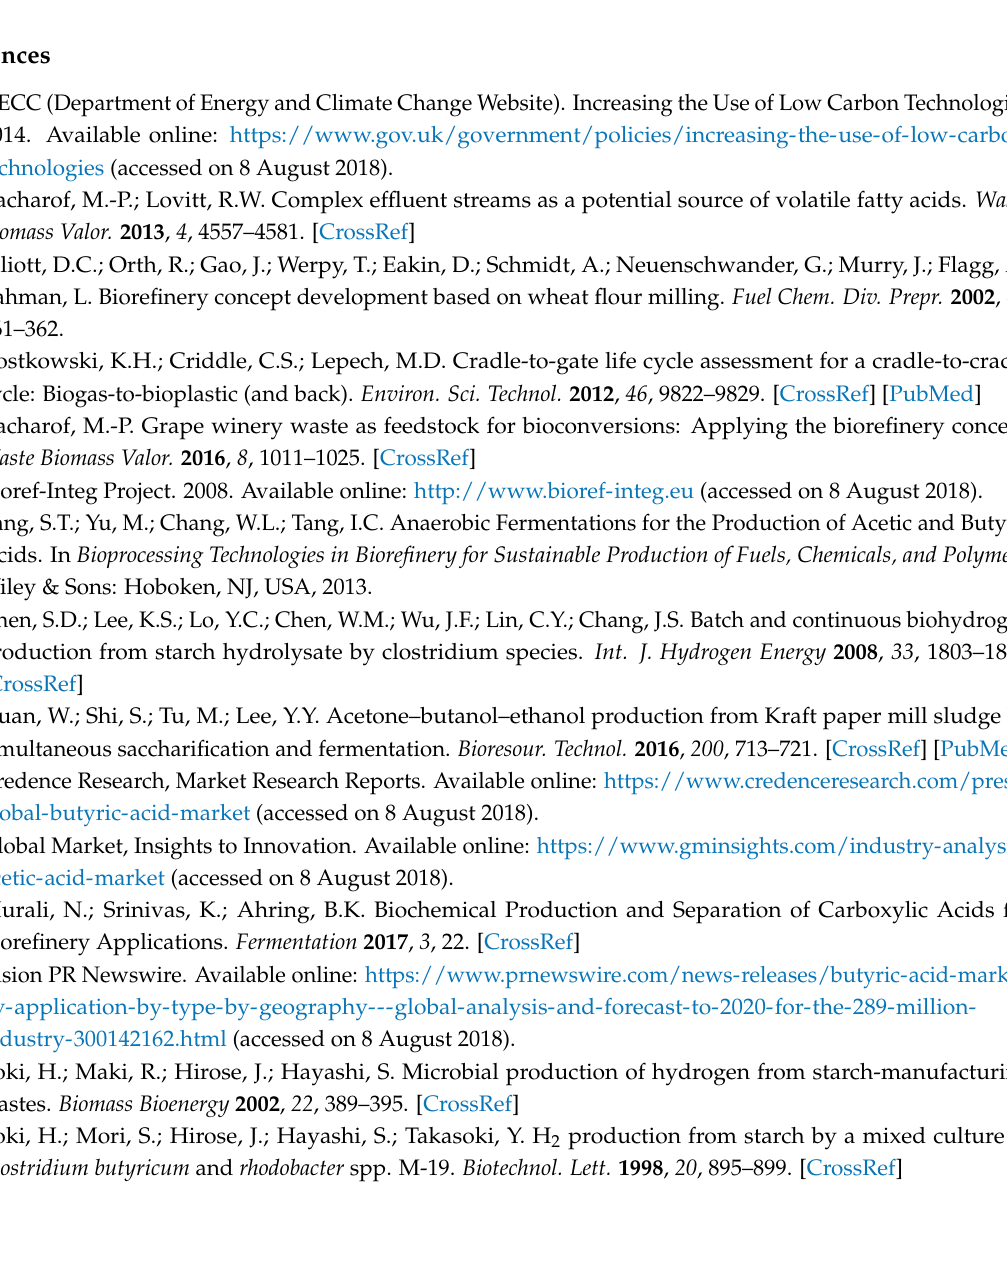
Figure S1: (a) SEM image of pure cultures of C. butyricum NCIMB 7423 used in this study (b) Biochemical pathways used during microbial metabolism of C. butyricum